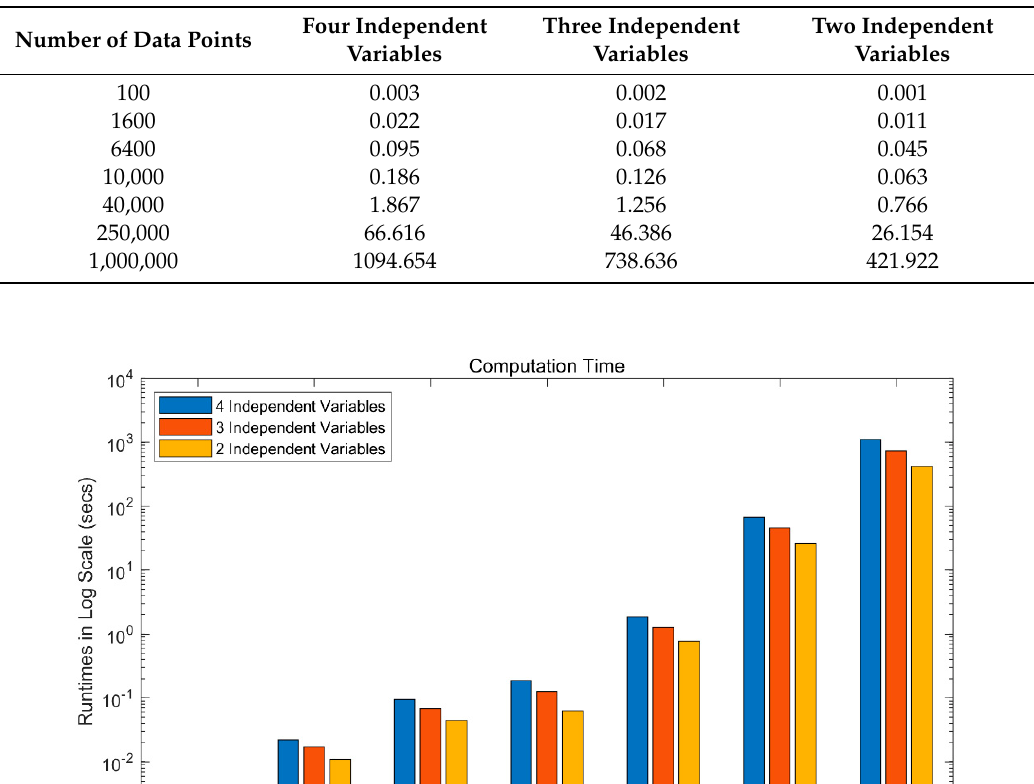
Table 3. Performance comparison for different types of graphics processing unit (GPU).